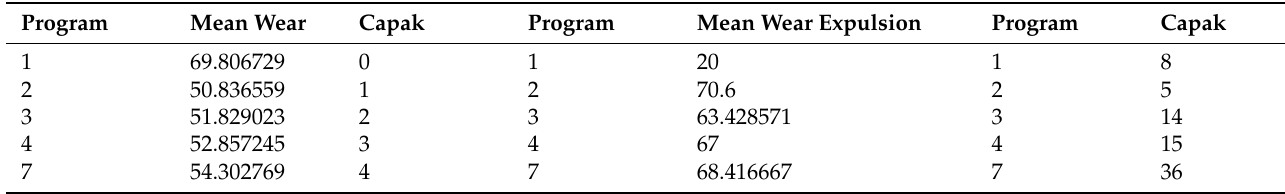
Table 6. Program, wear, and expulsion